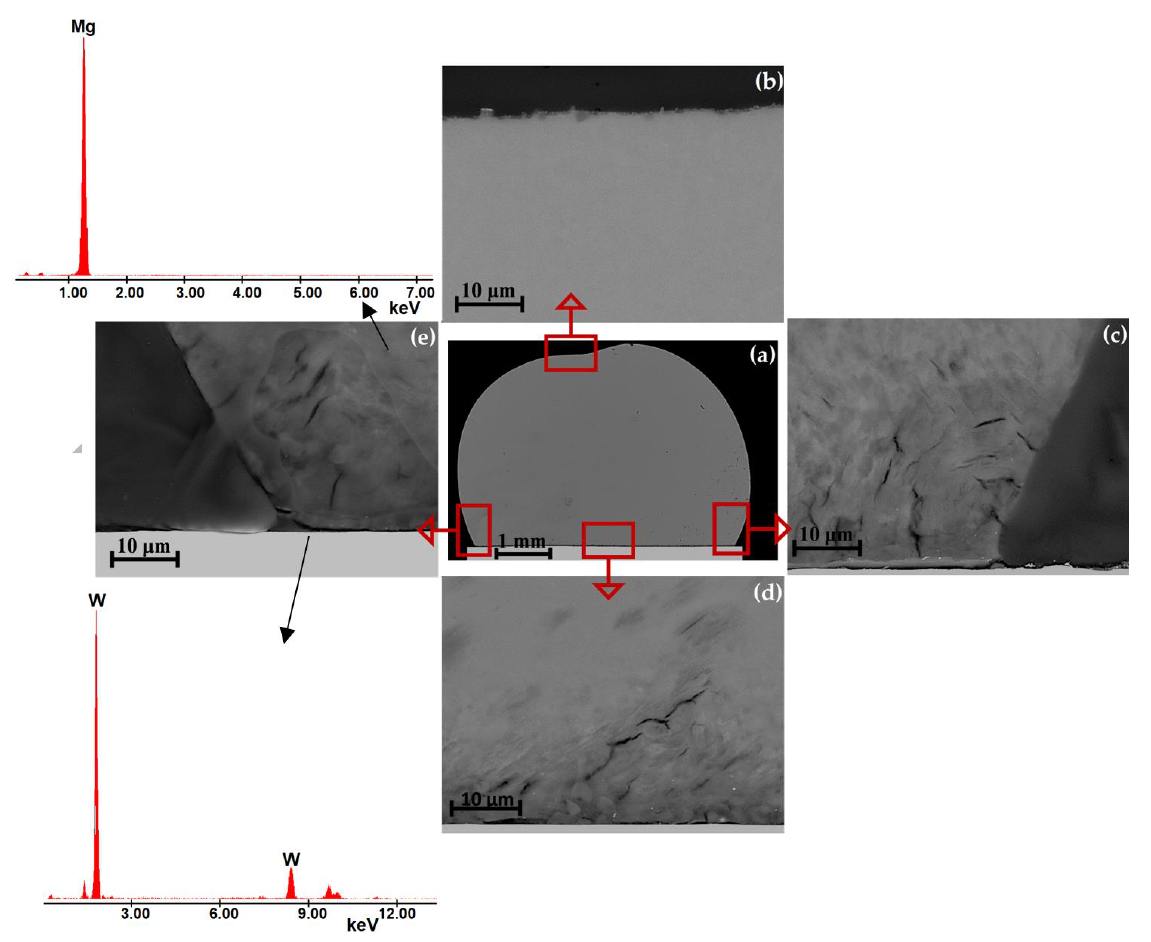
Figure 9. SEM images of a cross-sectioned Mg/W couple (CP: 700 °C, 180 s, Ar + 5 wt.% H 2 ) taken with a BSE detector at ( a ) magnification 50× and ( b – e ) magnification 5000×; ( b ) top of the drop, ( c ) right drop edge, ( d ) drop/substrate interface, and ( e ) left drop edge with EDS spectra of spot analysis.